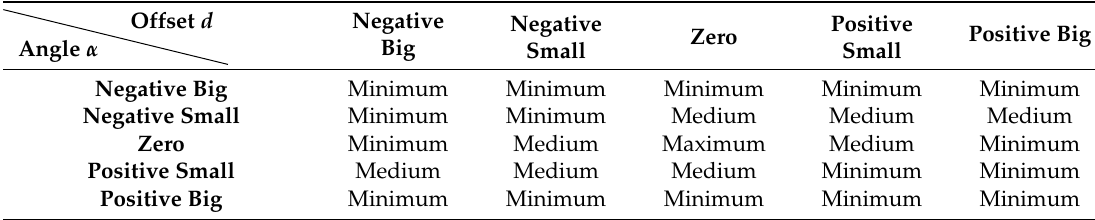
Figure 12. Fuzzy sets for the output variables: ( a ) angular speed and ( b ) linear speed.